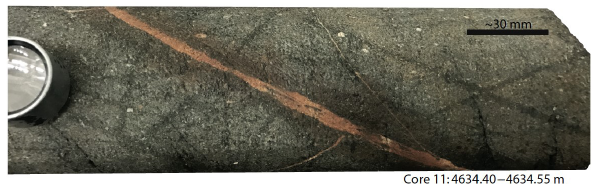
Figure 7. A piece of core from the RN-15/IDDP-2 well from 4634.40 to 4634.55m depth, showing felsite veins and conjugate sets of older fractures/veins. The red color of the felsite relates to hematic stain formed from a mixture of supercritical vein fluid with cold oxidizing drilling fluid (see text for further